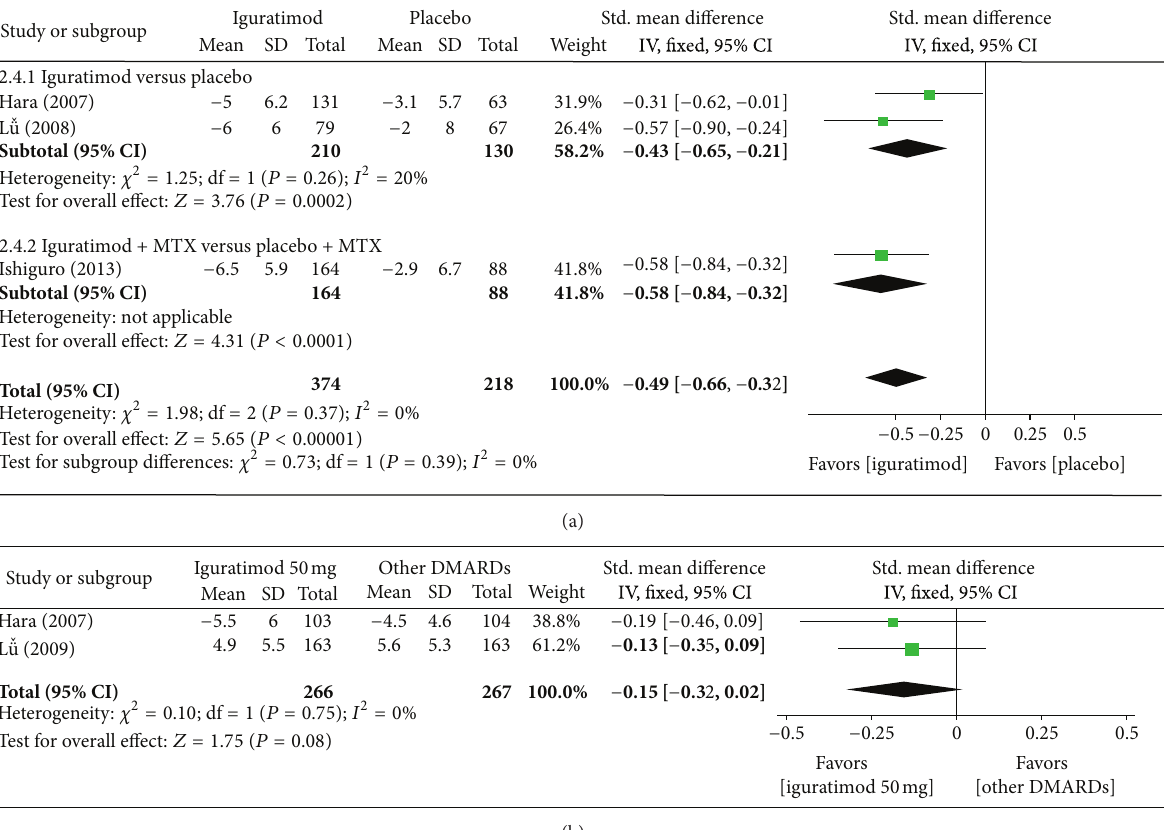
Figure 6: (a) Comparison of swollen joint count between iguratimod and placebo groups. (b) Comparison of swollen joint count between iguratimod and other DMARDs (MTX and SASP)